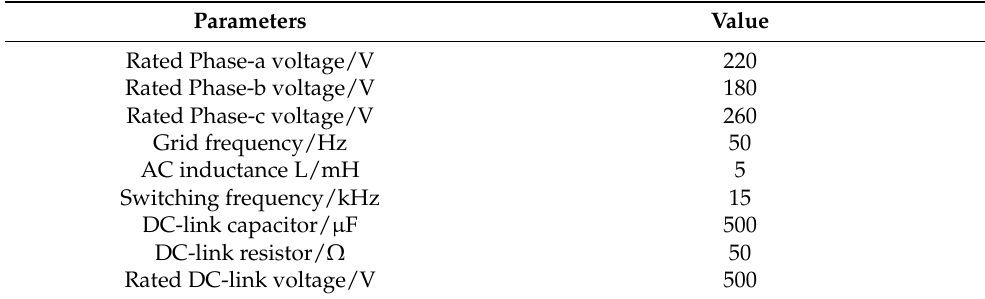
Table 1. Main circuit parameters of prototype.